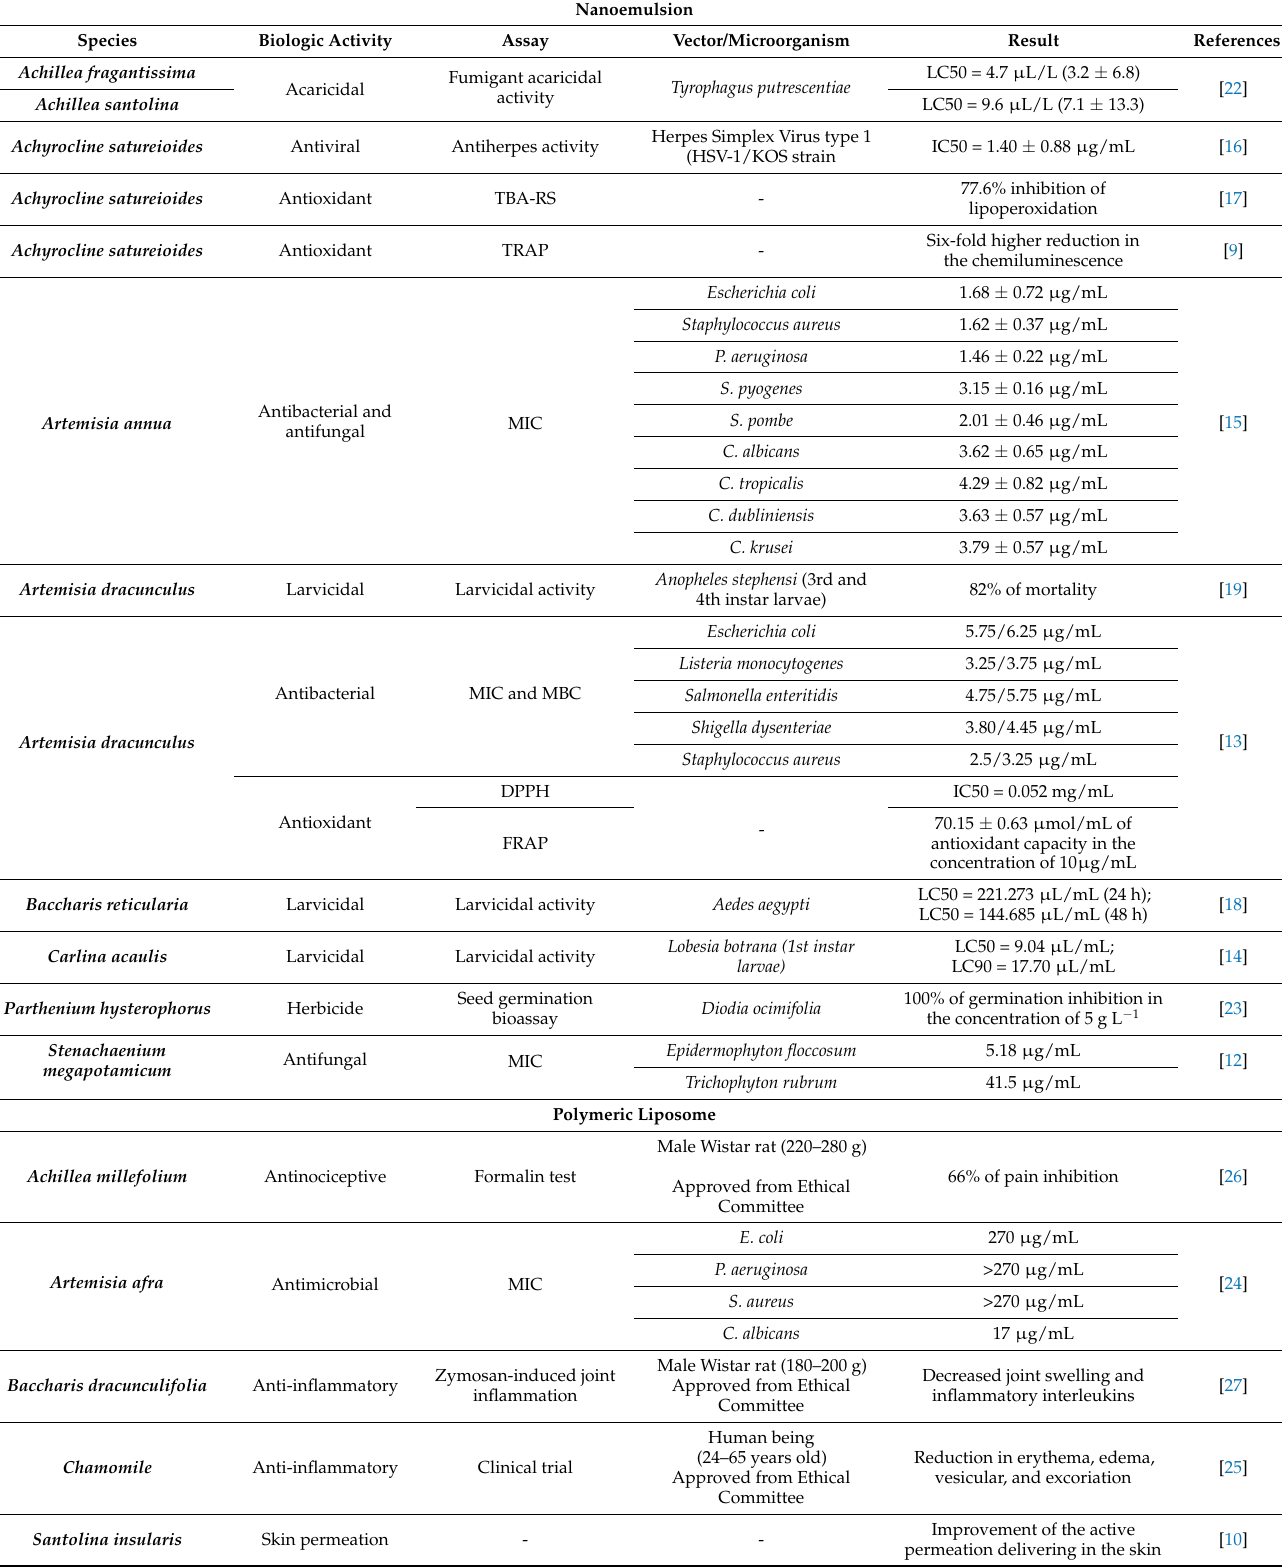
Table 4. Biological activities and assays performed for each formulation